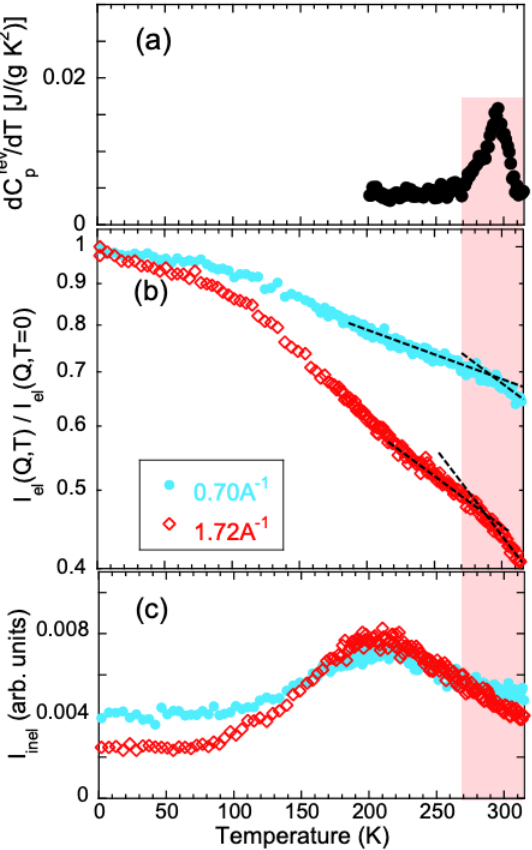
Fig. 4. Temperature dependence of results on the pure resin: (a) temperature derivative of the specific heat; (b) elastic intensity normalized to its extrapolated value at T =0; (c) inelastic intensity at 2 µ eV. Neutron scattering results correspond to the two Q -values indicated. Red area covers the calorimetric glass-transition region.